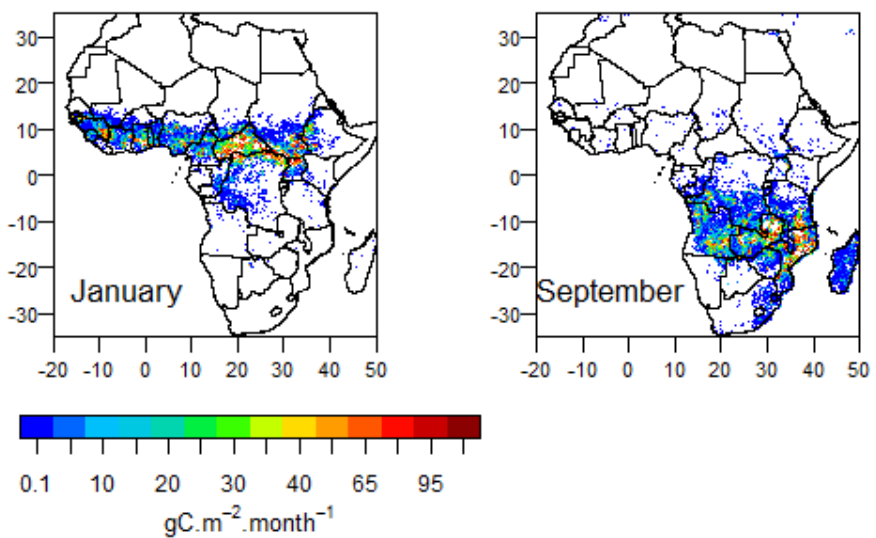
Figure 4. Carbon emissions by biomass burning for January 2015 and September 2015 obtained from GFED4s data.